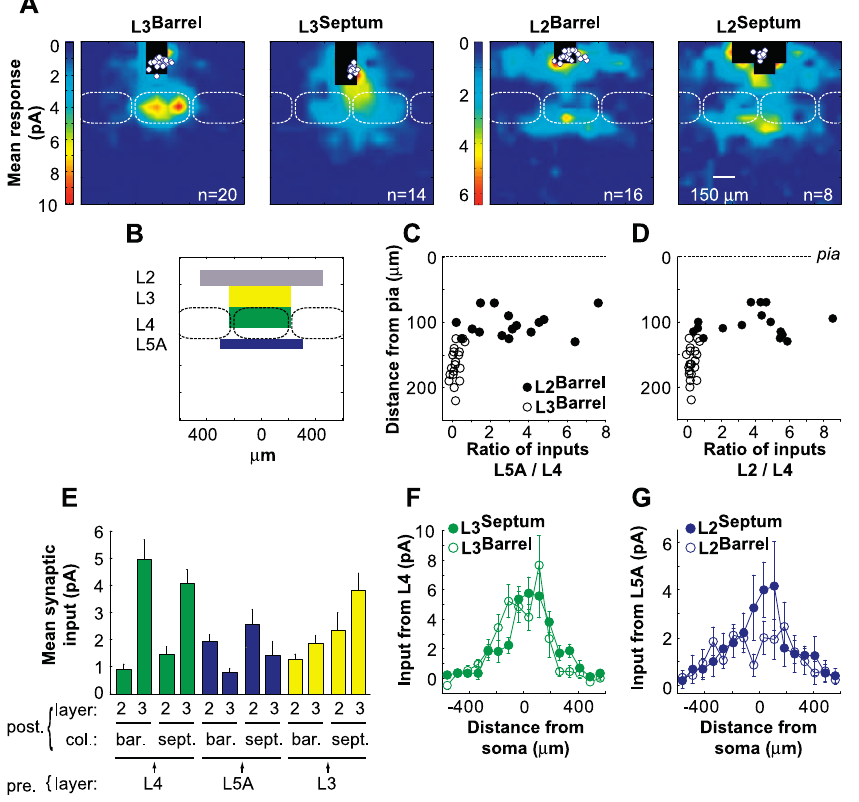
Figure 8. Interdigitated Intracortical Relays (A) Average synaptic input maps for positionally defined L2/3 pyramidal cells. (B) Regions of interest used for the analysis in (C–E). (C) The ratio of input from L5A/L4 as a function of the depth of the soma of barrel-related neurons. Dashed black line (top) indicates the pia. (D) The ratio of input from